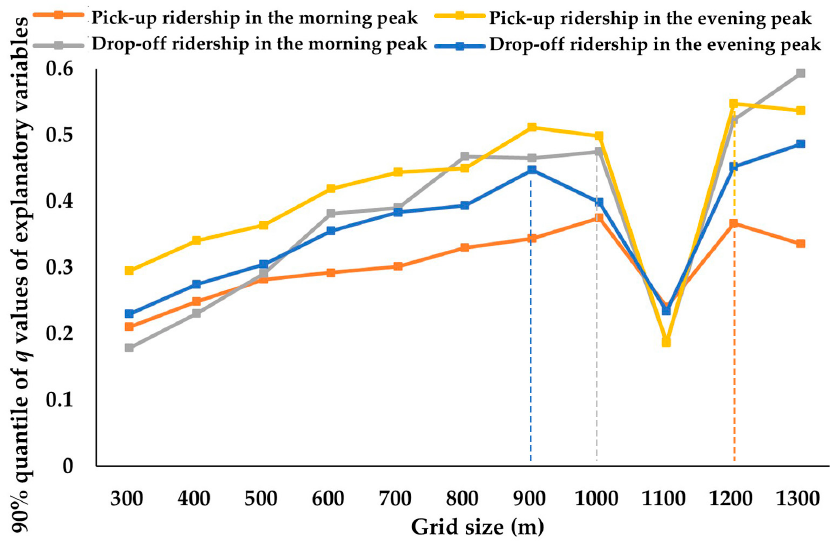
Figure 7. Comparison of 90% quantile of q values for explanatory variables under different grid sizes.